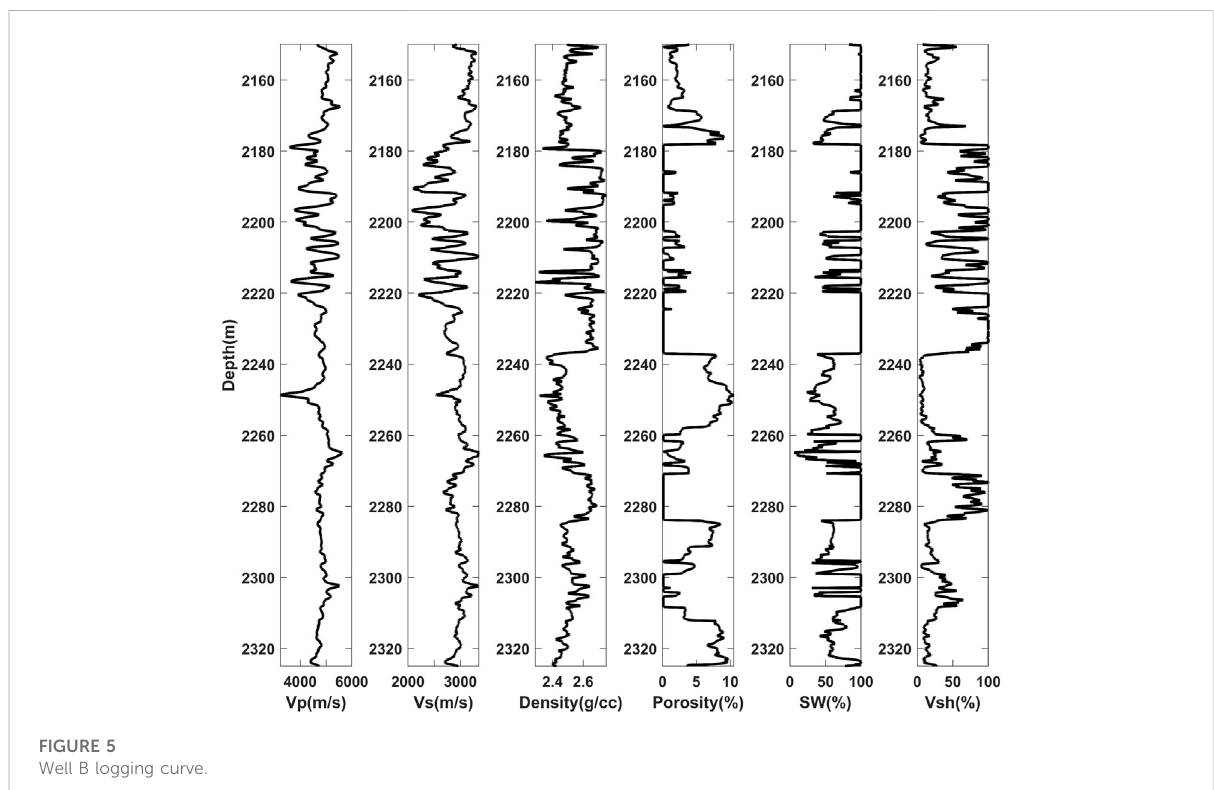
FIGURE 5 Well B logging